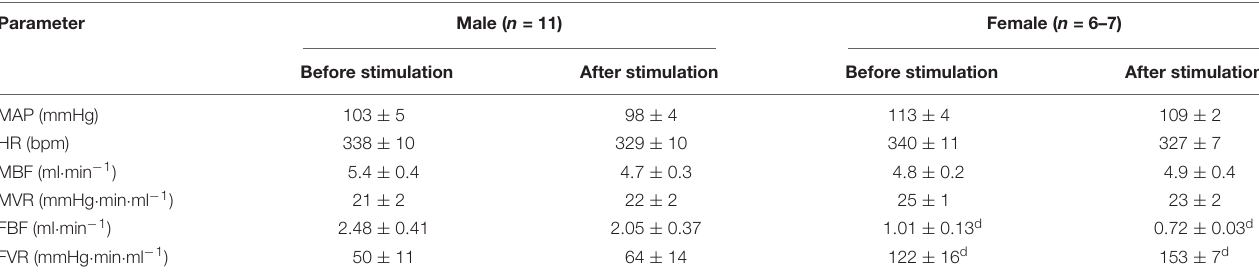
TABLE 1 | Baseline hemodynamic measures in urethane-anesthetized male and female Sprague Dawley (SD) rats.